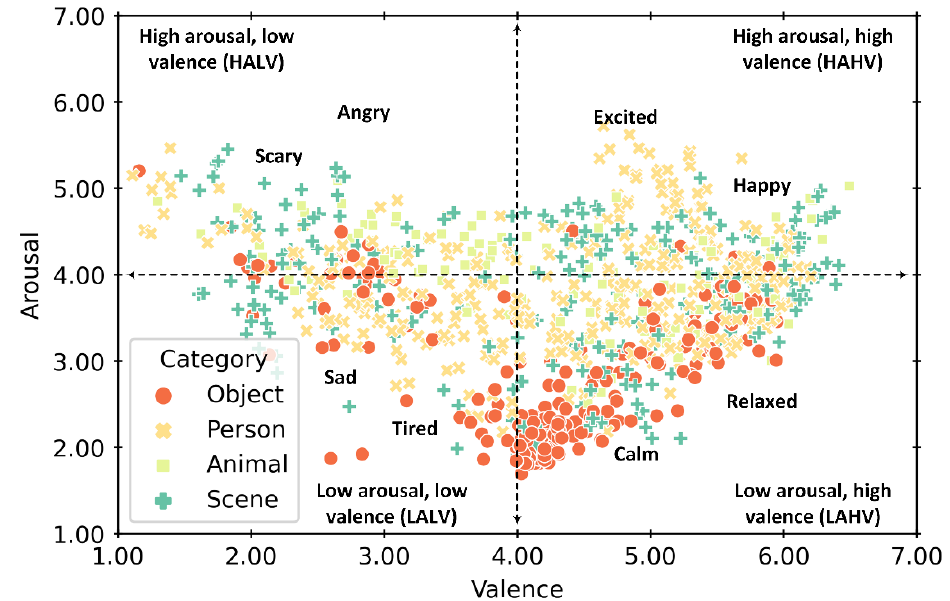
Figure 1. Picture stimuli from the OASIS dataset as an example of the dimensional emotion model (measured on a 1–7 Likert scale) with valence on the x -axis and arousal on the y -axis. The markers denote four different image categories: object, person, animal, and scene. Approximate positions of discrete emotions are indicated. For more information on the dimensional model, see [28–30]. Reproduced with permission from Kurdi, B.; Lozano, S.; Banaji, M.R., Introducing the open affective standardized image set (OASIS); published by Springer, 2017.